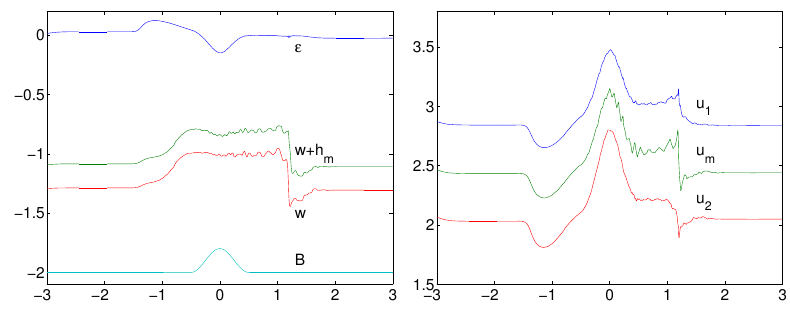
Figure 11. Example 2: Solution of the three-layer system with (cid:98) h m = 0 . 2.